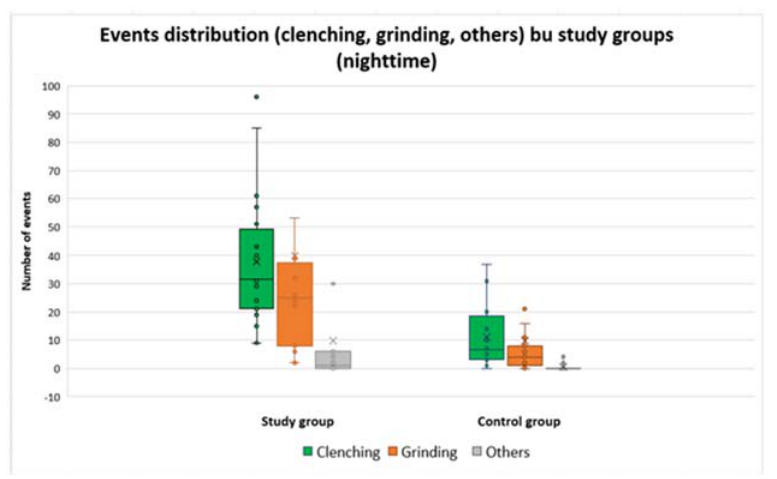
Figure 3. Distribution of clenching, grinding, and other types of events, for the two groups, during nighttime.